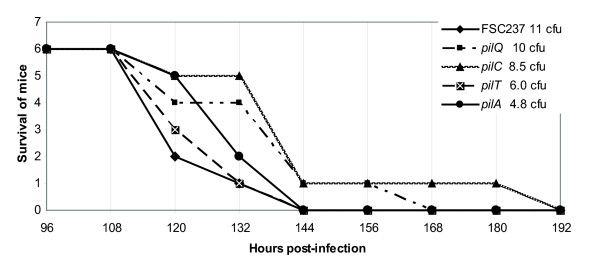
Infection kinetics are slightly delayed for mice infected with the pilA, pilC, and pilQ deletion strains. Groups of six mice were infected via the subcutaneous route and the survival followed over time. The exact dose for each strain was determined by retrospective viable count.